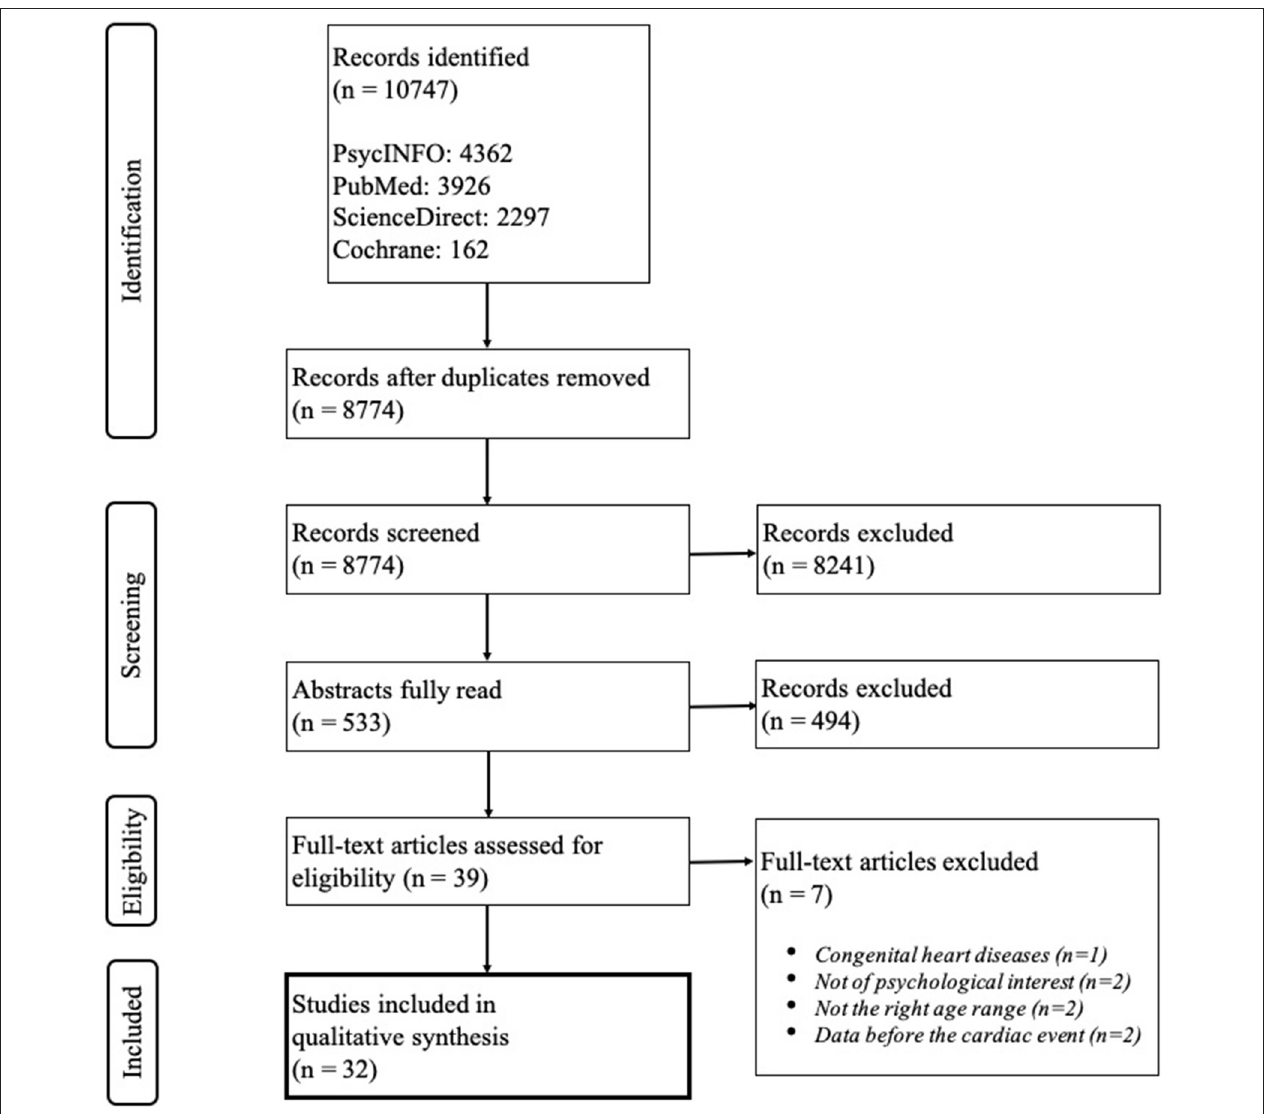
FIGURE 1 | Flow diagram of the study